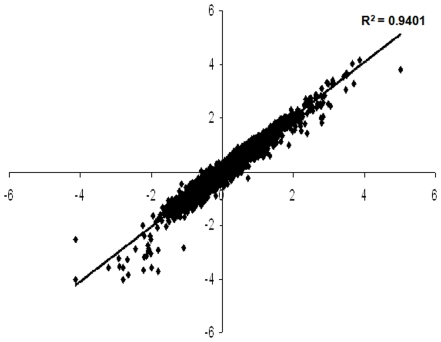
Scatter plot of average Z score values from treated (Mtb/Hcl1) and control (Mtb/pVV16) samples obtained after Z score transformation.Data points represent the average Z score values of genes obtained from six arrays.